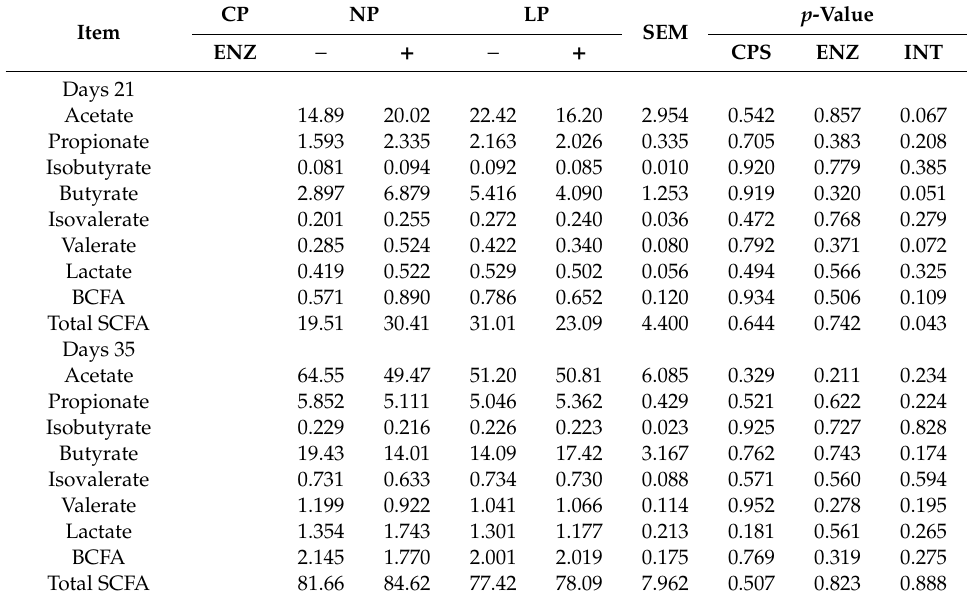
Table 8. E ff ects of low-protein diet and exogenous protease on concentrations (mM / g digesta) of cecal short-chain fatty acid (SCFA) in broiler chickens.